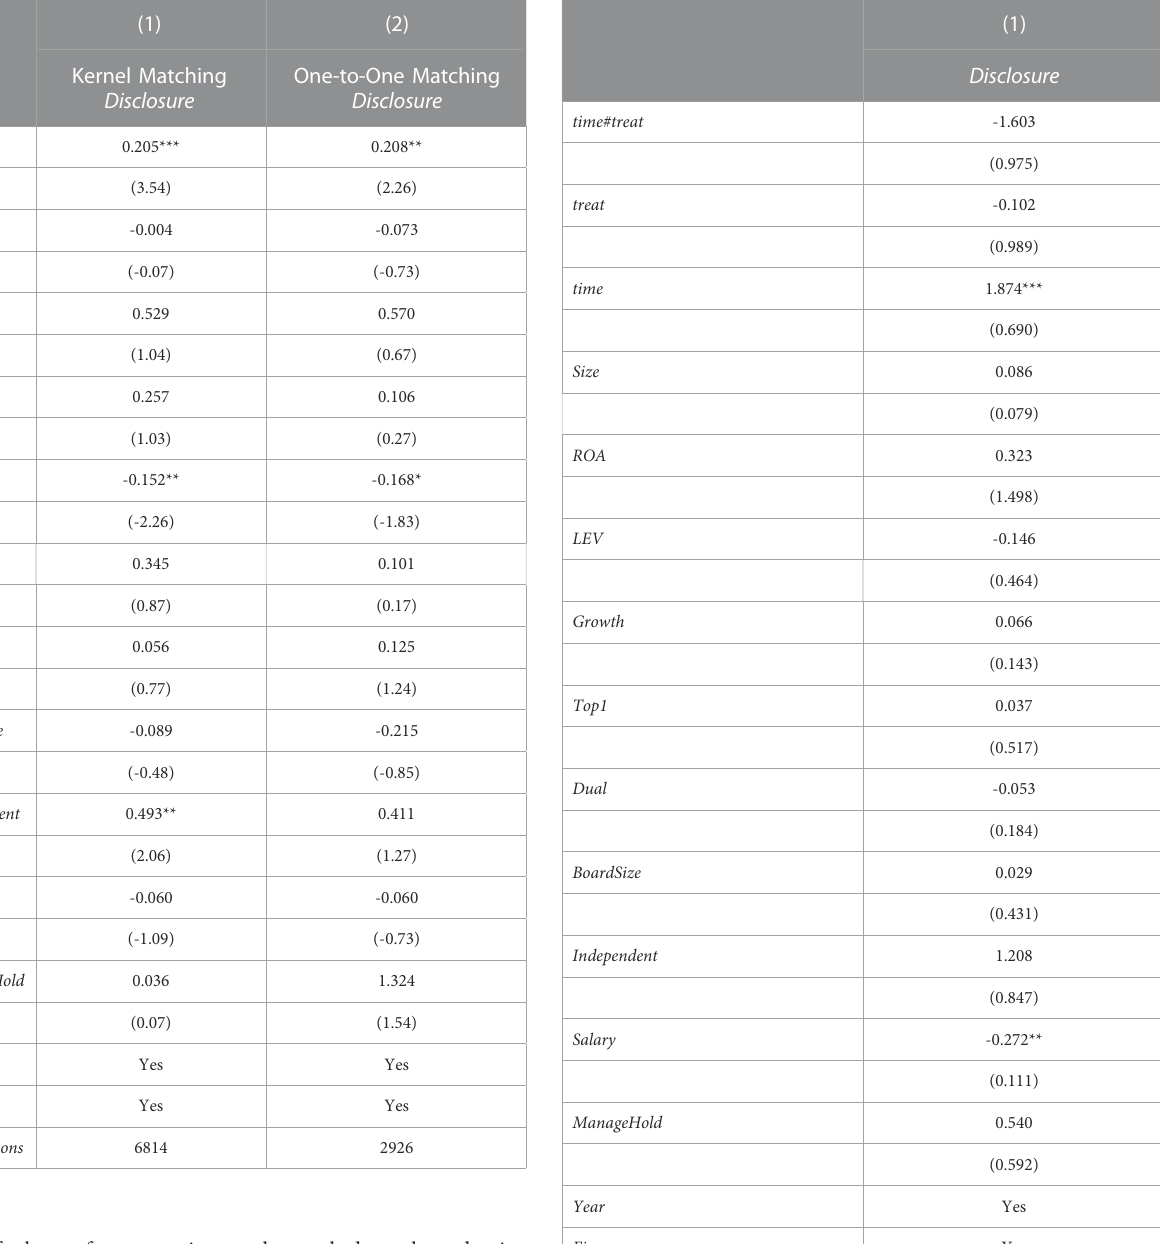
TABLE 10 The Impact of Capital Market Liberalization on the ESG Disclosure after PSM: This table presents the impact of capital market liberalization on corporate ESG disclosure after PSM. The dependent variable Disclosure represents the corporate ESG disclosure level, which is calculated by scoring the ESG-related information disclosure for each fi rm. The independent variable HSC isadummyvariablethattakesthevalueoneifthe fi rmentersthe list of mainland-HK Stock Connect schemes, and zero otherwise. The control variablesinclude fi rmsize( Size ),returnontotalassets( ROA ), fi nancialleverage ( LEV ), growth rate ( Growth ), ownership concentration ( Top 1), integration of two positions ( Dual ), board size ( BoardSize ), independent director ratio ( Independent ), top three executives ’ compensation ( Salary ), and management shareholding ratio ( ManageHold ). Year fi xed effects( Year ) and fi rm fi xed effects( Firm ) are both included. Refer to Table 1 for detailed variable de fi nitions. t -statistics are reported in parentheses.***, ** and * denote signi fi cance levels at 1%, 5% and 10%, respectively.